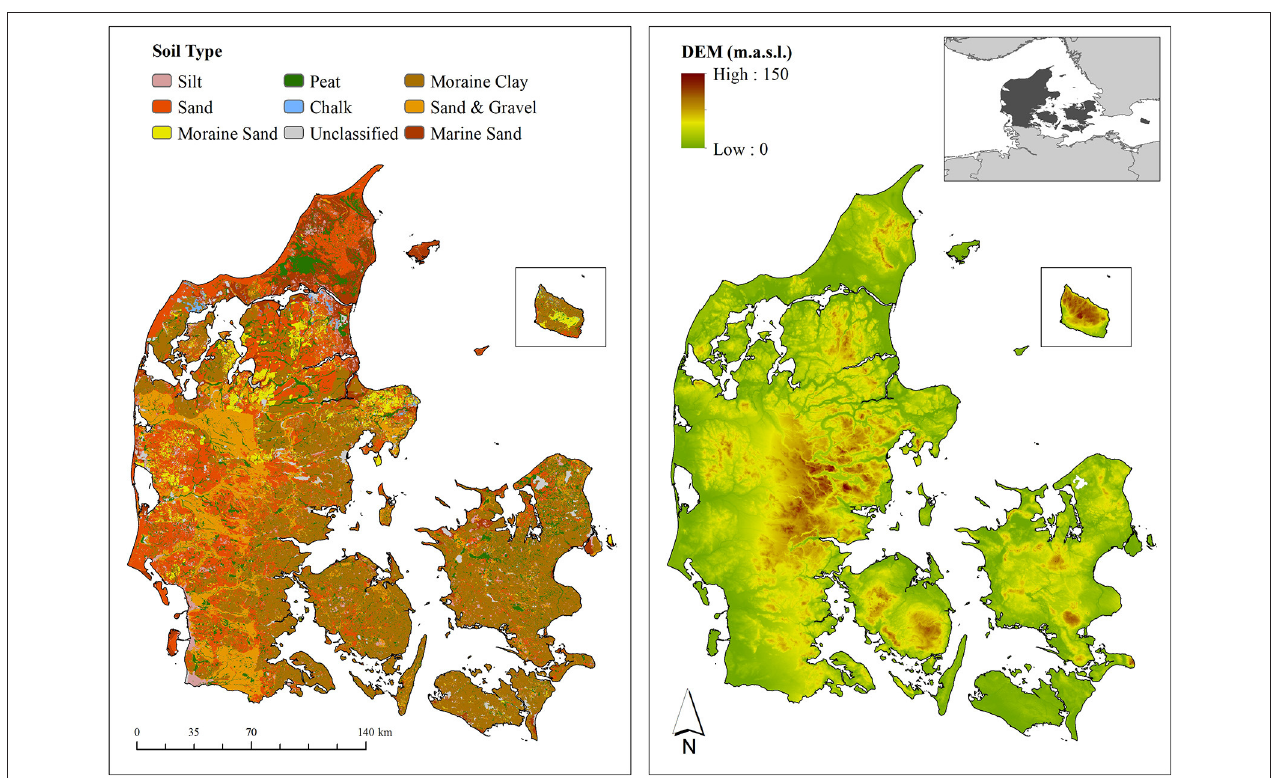
FIGURE 1 | The left panel depicts the soil types of Denmark classified into nine dominant classes (Henriksen et al., 2020). The right panel depicts a digital elevation map of Denmark. The Island Bornholm, located in the Eastern Baltic sea (see overview map), is added as an independent map layer to both panels.